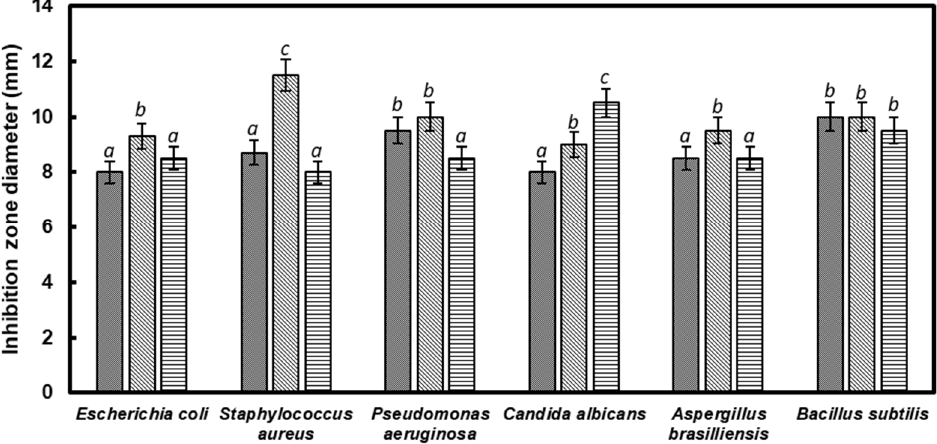
Figure 4. Antimicrobial activity of olive oil measured by the growth inhibition zones in the agar disc diffusion method: refined olive oil (dotted), ozonated olive oil 0.04 mole O 3 /100 g oil (diagonally); ozonated olive oil 0.10 mole O 3 /100 g oil (striped); the same letters indicate no statistically significant differences ( p < 0.05); different letters indicate statistically significant differences ( p < 0.05).